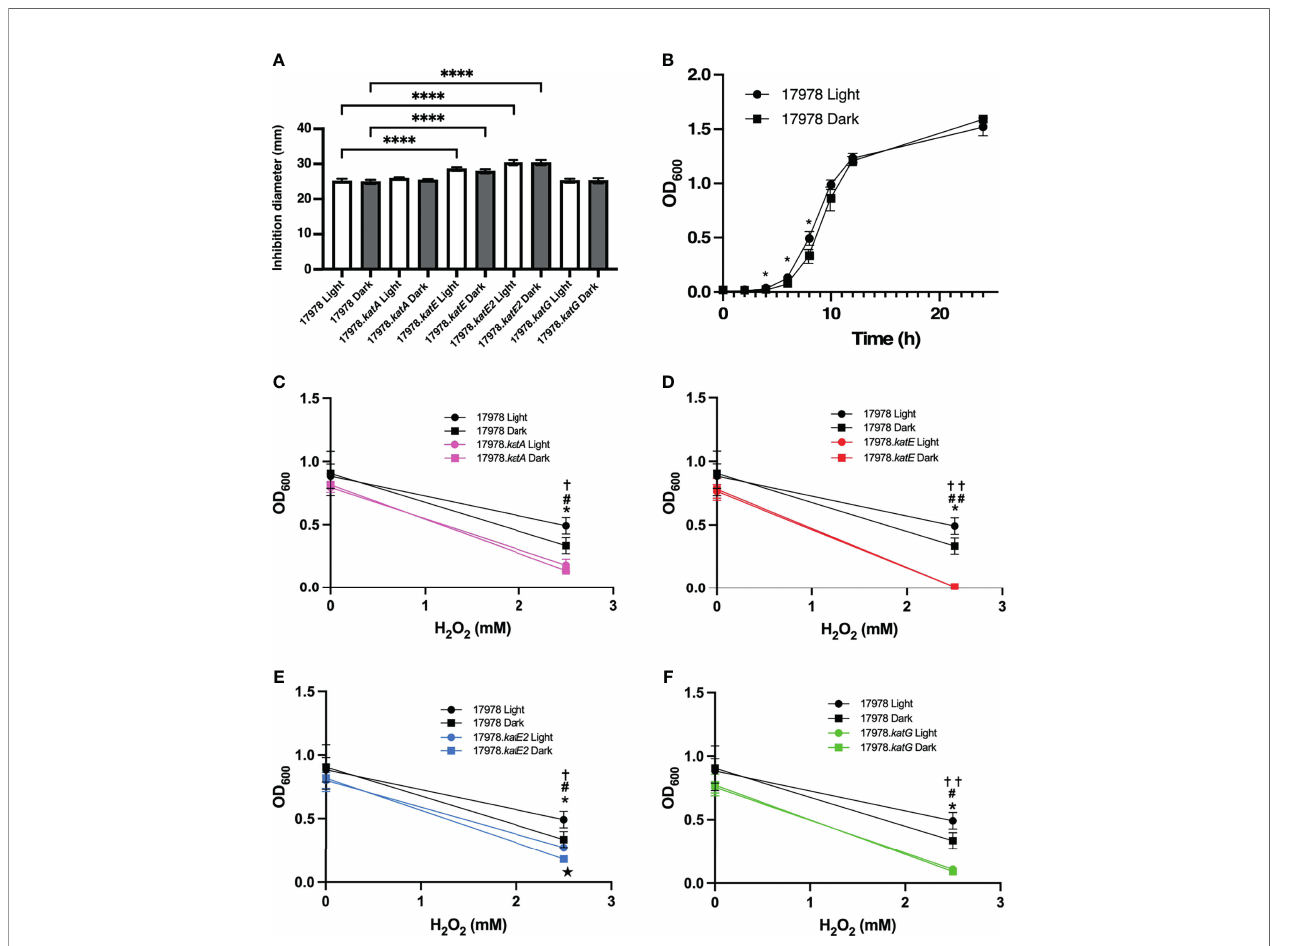
FIGURE 4 | The effect of light on peroxide resistance of 17978 catalase mutants. The impact of blue light on the peroxide resistance of the 17978 wildtype and isogenic catalase mutants grown at 24°C was measured by two methods. (A) The resistance of wildtype and catalase mutant strains under blue light or in darkness was analyzed using H 2 O 2 disc diffusion analysis. The averages of diameters of inhibition from three independent experiments are shown ( n = 3), and error bars represent the standard deviations of the data sets. Horizontal bars with symbols indicate results of ordinary one-way ANOVA with Sidak ’ s multiple comparisons post-hoc test (**** P ≤ 0.0001). (B) 17978 wildtype bacteria were grown under blue light or in darkness in SB supplemented with 2.5 mM H 2 O 2 at 24°C with shaking, and optical density was measured over time. Error bars represent the standard deviation of each data set. Horizontal bars with symbols indicate results of unpaired t test analysis (* P ≤ 0.05). (C – F) Growth of catalase mutants compared to wildtype bacteria at 8 h when grown in SB or SB supplemented with 2.5 mM H 2 O 2 under blue light or in darkness. Growth data are the average of at least two individual growth experiments for each strain, and error bars represent the standard deviations of the data sets. Horizontal bars and symbols indicate results of unpaired t test analysis (* P ≤ 0.05 between 17978 Light and Dark; ✝ P ≤ 0.05 between 17978 Light and respective kat mutant Light; # P ≤ 0.05 between 17978 Dark and respective kat mutant Dark; ★ P ≤ 0.05 between respective kat mutant Light and Dark; ✝✝ P ≤ 0.01 between 17978 Light and respective kat mutant Light; ## P ≤ 0.01 between 17978 Dark and respective kat mutant Dark). Only statistically signi fi cant differences are noted on the graphs. Full growth curve data are shown in Supplementary Figure 5